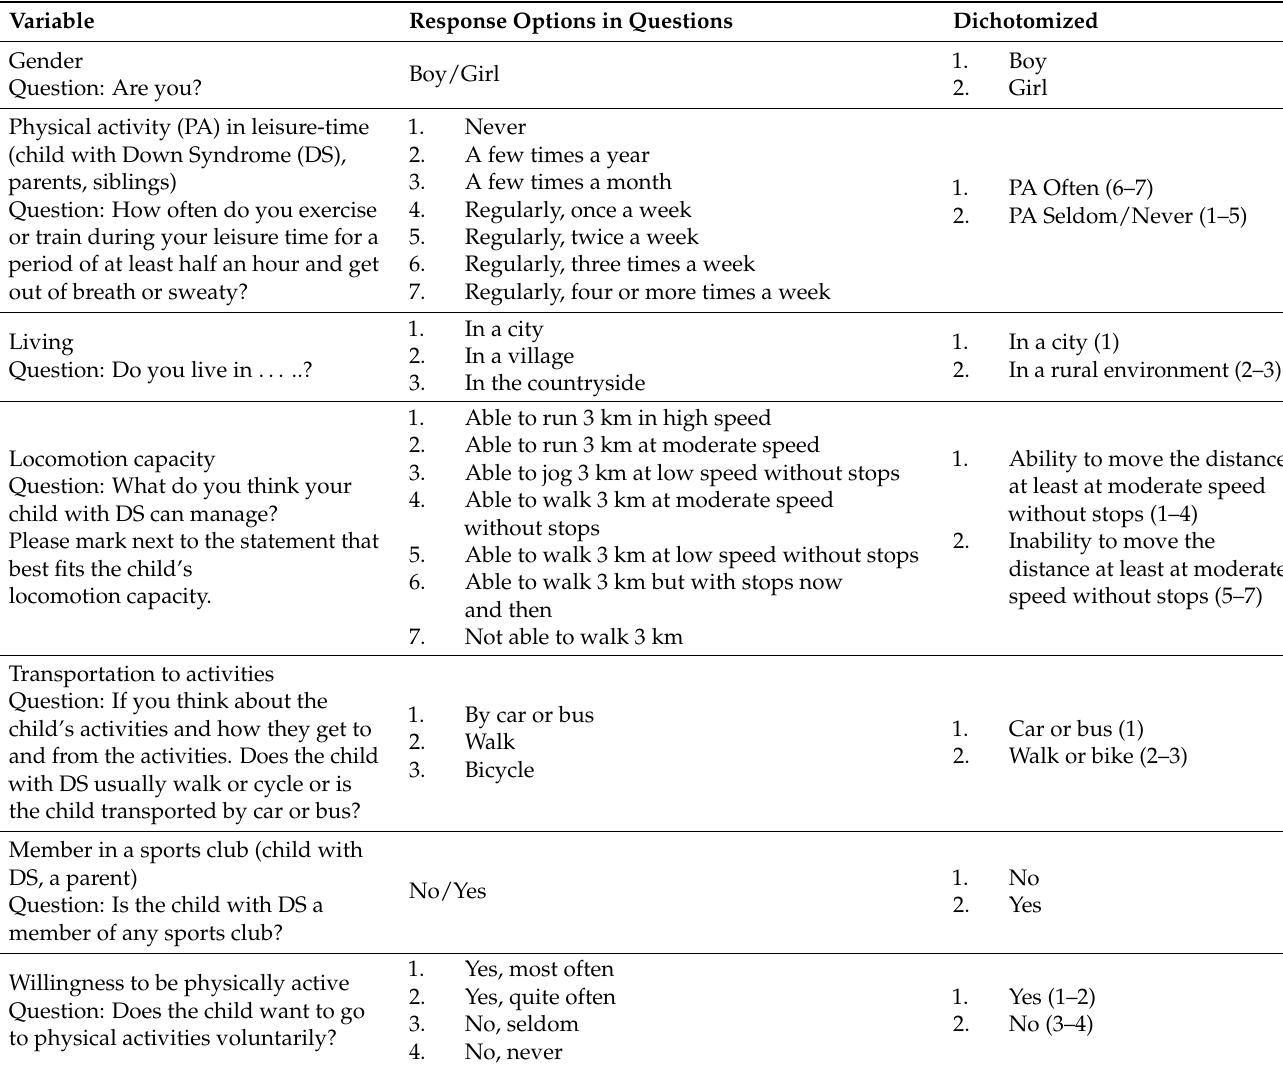
Table 1. Variables with corresponding questions from the survey, response options in the survey and dichotomization for statistical comparison between